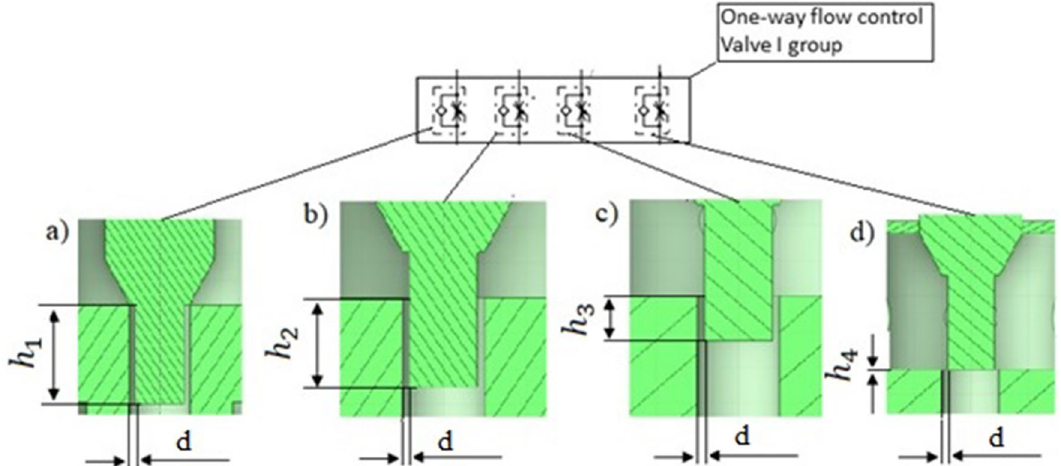
3 m: ( a ) h 3 m, ( b ) 0, 175 10 3.95 10 Figure 4. Cross sections of four opening valve heights for d 1 − − = × = × 3 m, ( d ) h 3 m, ( c ) h h 1.43 10 2.69 10 0 . [Ansys Fluent 2021 R2 (ANSYS Academic Research 3 2 4 − − = × = × = Mechanical and CFD): https:// downl oad. ansys. com/ Curre nt% 20Rel ease? relea seno= 2021% 20R2& opera tings ystem= Windo ws% 20x64].